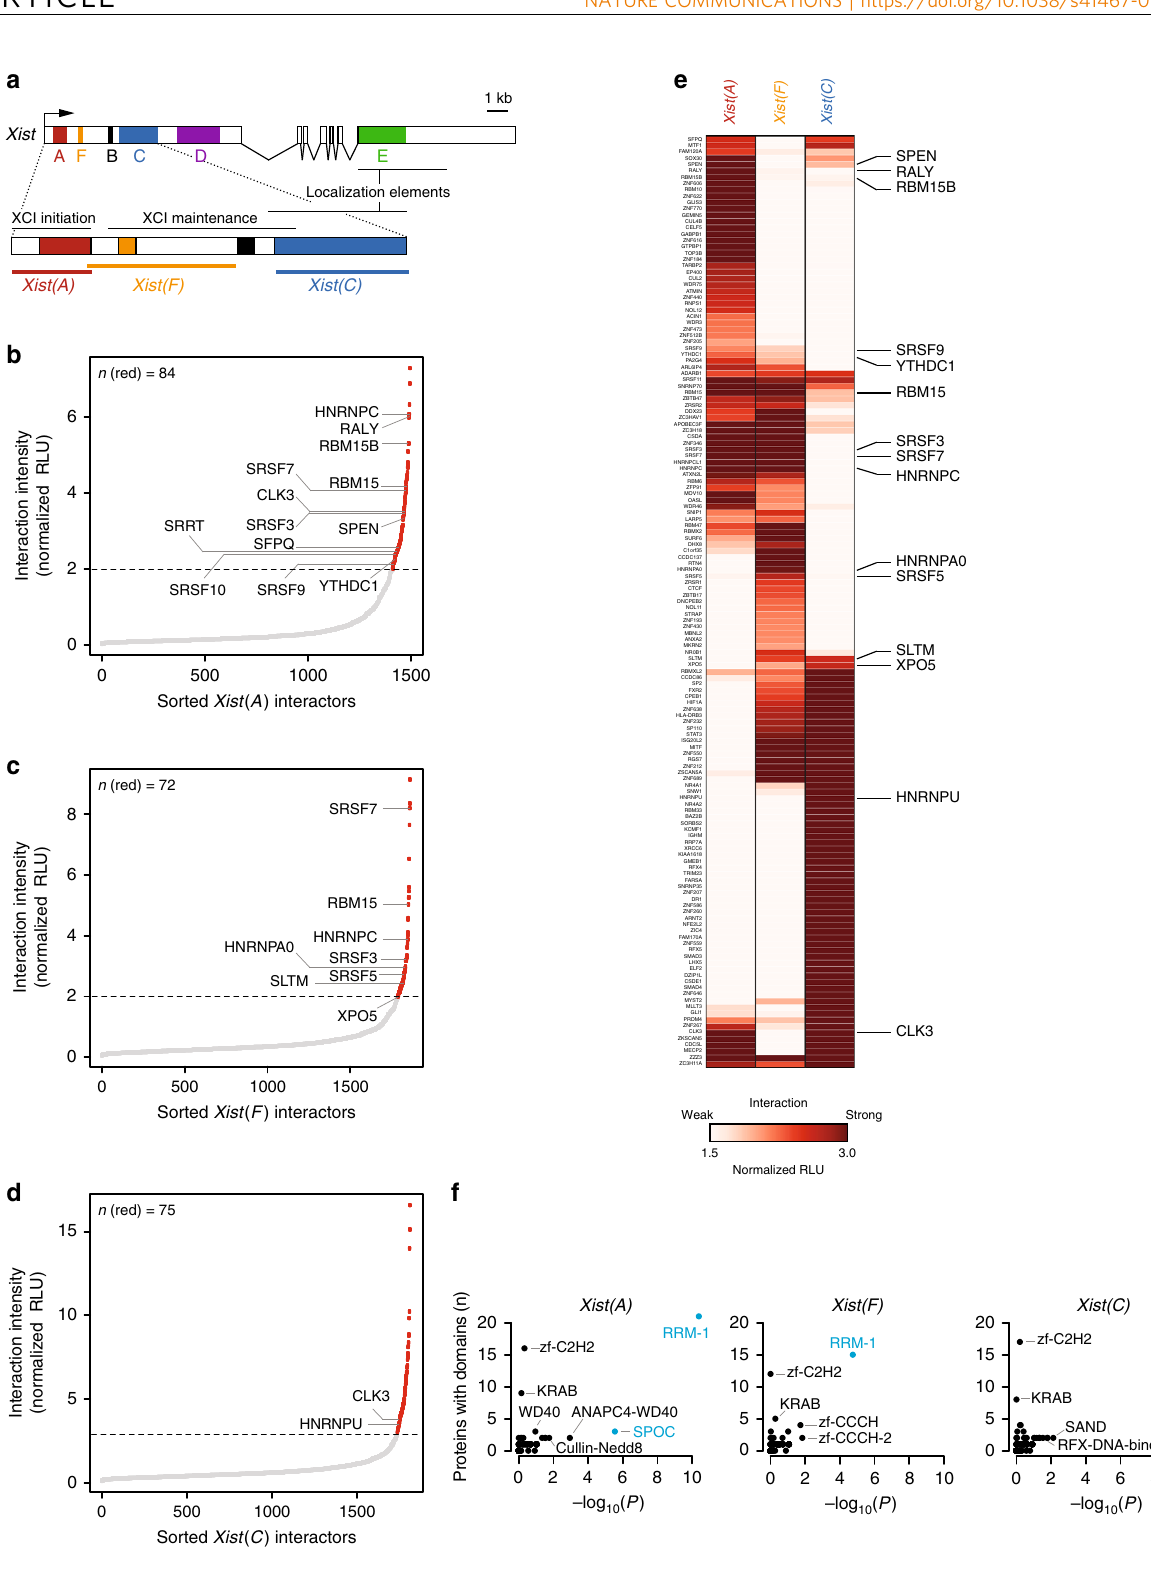
interactions uncovered using incPRINT are functionally relevant. The focus was on the ZZZ3 protein, which interacts with all three tested Xist regions, and RBM6, which exhibits more speci fi c binding to the Xist(A) and Xist(F) regions (Fig. 4e). First, we con fi rmed the interaction of Xist with RBM6 and ZZZ3 under endogenous conditions by testing Xist co-precipitation with both proteins in mouse embryonic stem (ES) cells. The proteins were